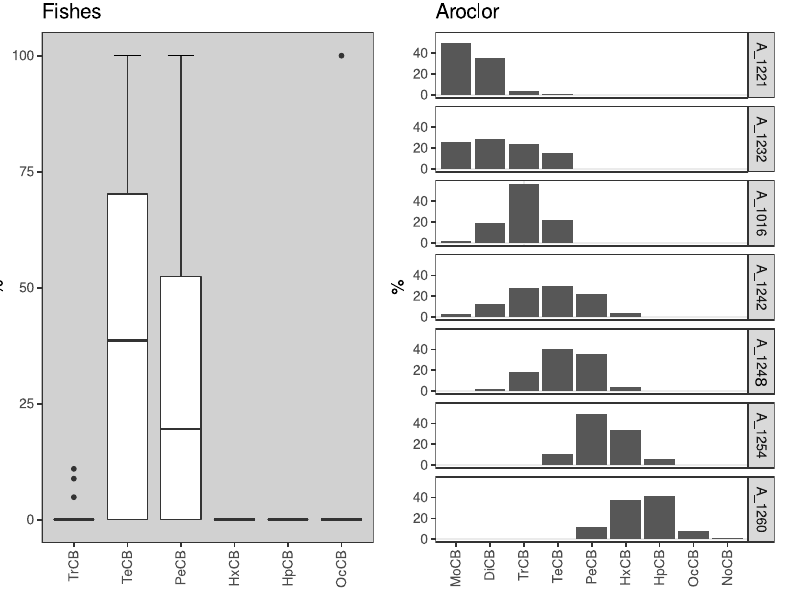
Figure 3. Box-plot indicating the relative distribution of PCBs (%) by chlorination level in S ardinella brasiliensis muscle samples from the five different sampling campaigns carried out herein. The PCB nomenclature reflects their chlorination level